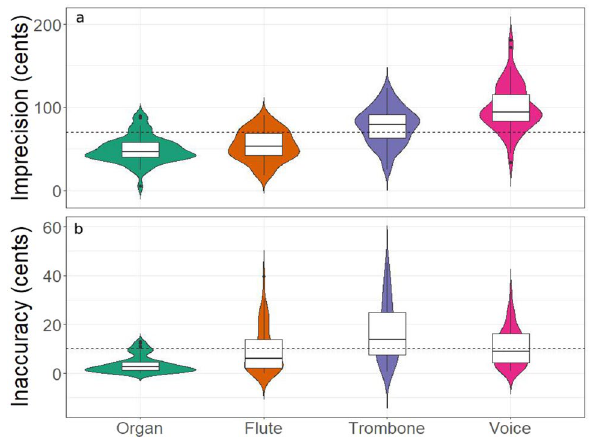
Figure 4. Instrumental pitch-class imprecision and inaccuracy. ( a ) The distributions of pitch-class range across instruments as a measure of pitch-class imprecision, shown as violin plots. ( b ) The distributions of pitch-class inaccuracy across instruments, shown as violin plots. The violin plots have the same properties as described in the legend of Fig. 3. The mean of each variable is represented by a dashed